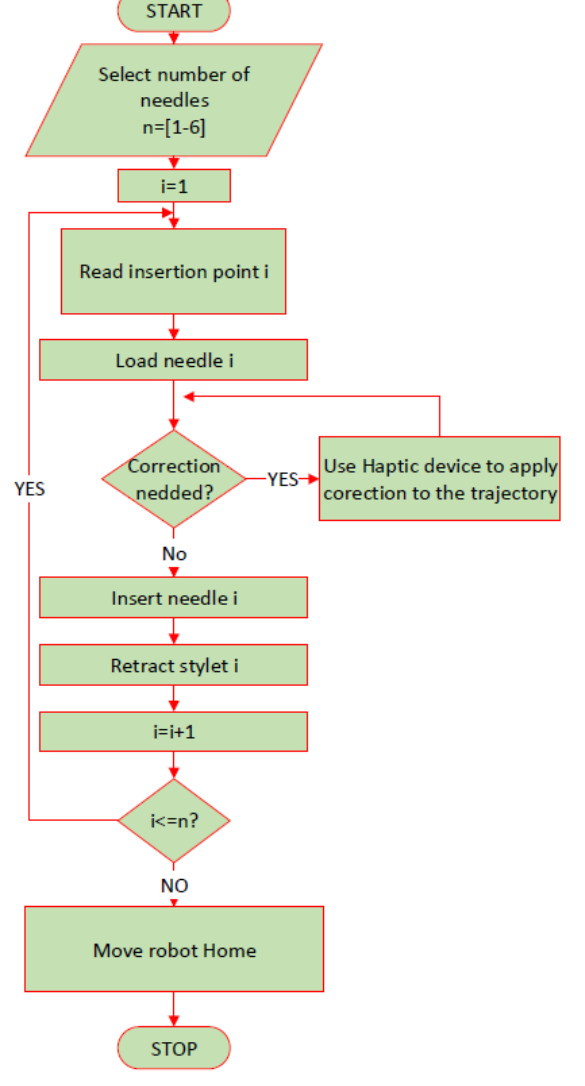
Figure 4. Robotic brachytherapy protocol.